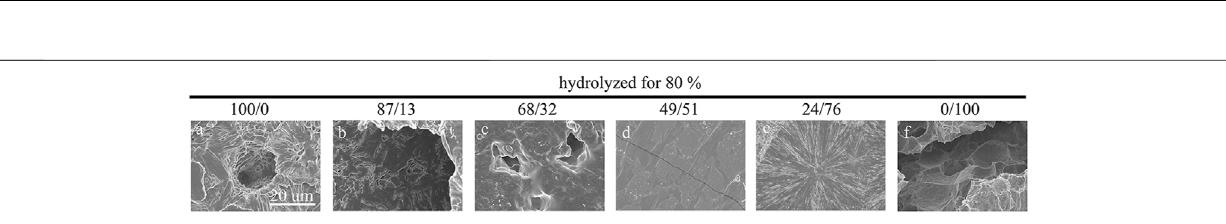
Frontiers in Bioengineering and Biotechnology |